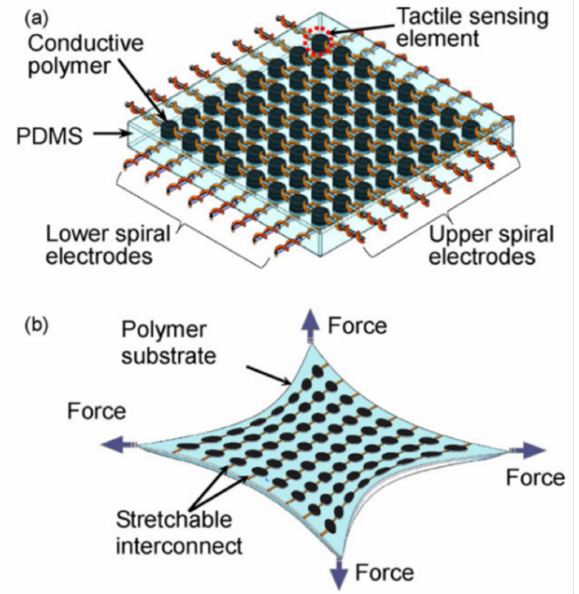
Figure 9. ( a ) The schematic of a tactile sensing array; ( b ) the sensing system under stretching [82]. Reproduced with